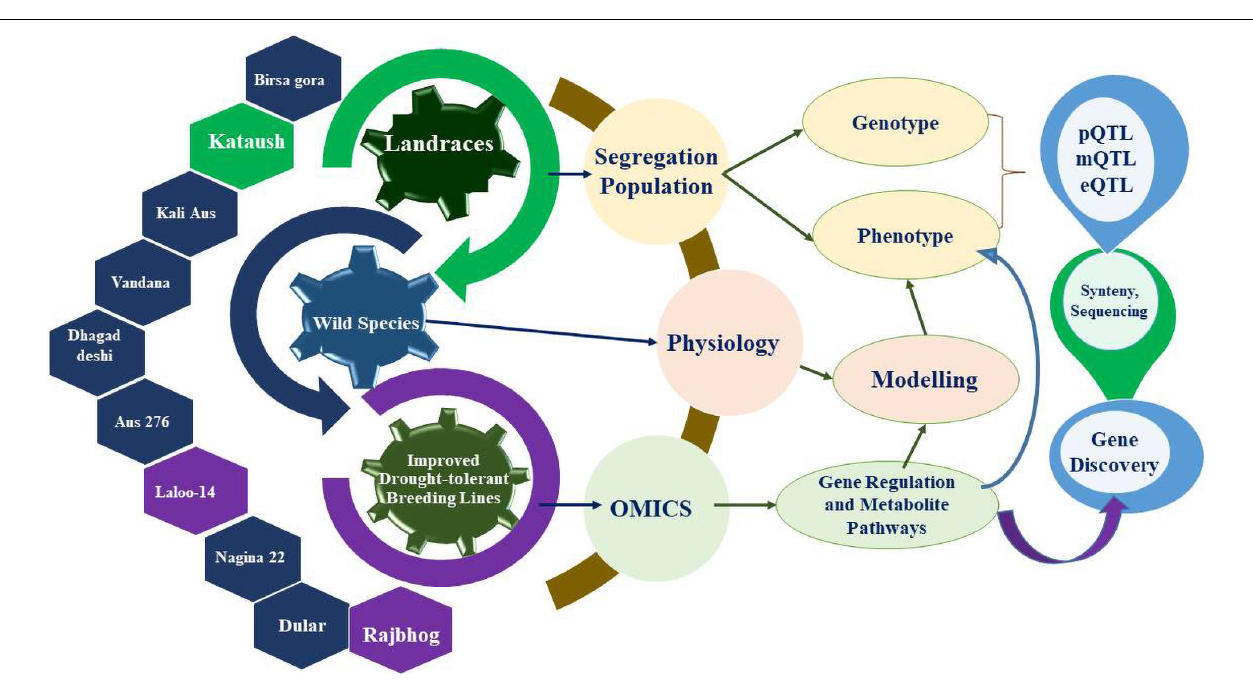
FIGURE 2 | Illustration of drought tolerant gene discovery in parental lines of rice plants by combined approaches of omics and physiological